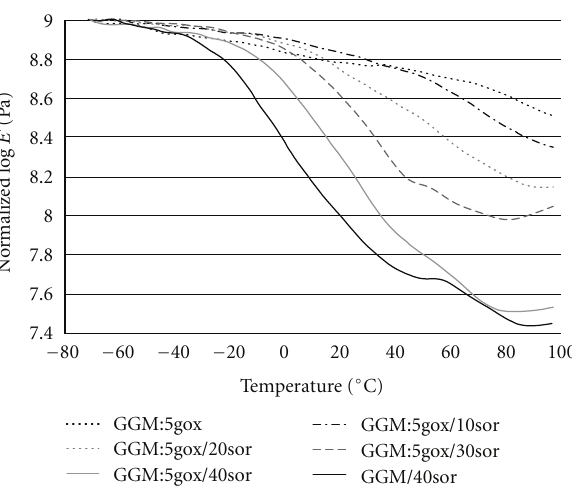
Figure 2: Logarithm of the storage modulus (E (cid:4) ) spectra of films conditioned at 50% RH. The E (cid:4) at − 70 ◦ C was normalized at 1 GPa for all the samples. Sample coding as presented in Table 1.